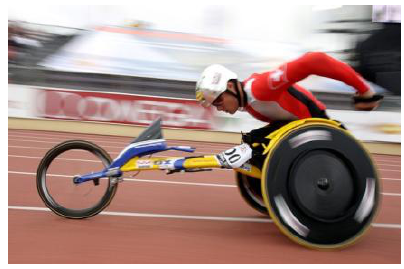
Figura 3. http://blogdodortaesporteclube.blogspot.com/2008_08_01 _archive.html